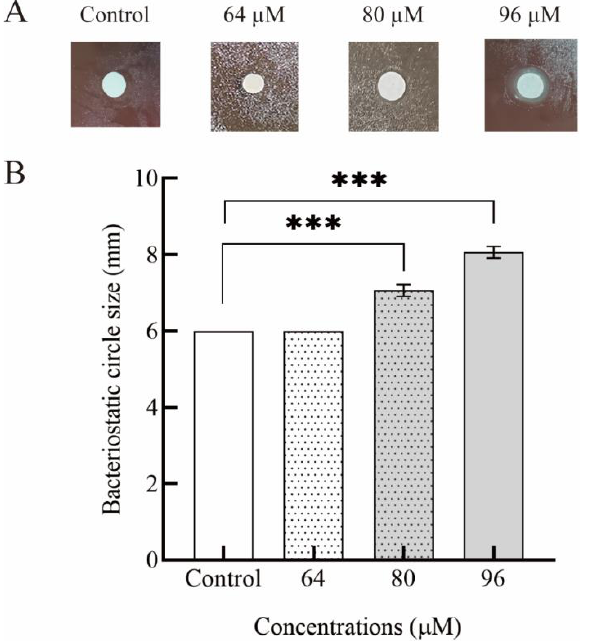
Figure 1. The diameter of the inhibition zone (DIZ) was determined by the filter paper diffusion method. The plates with H. pylori and PLNC8 were incubated at 37 ◦ C in a microaerobic environment for 72 h. ( A ) Inhibitory effect of 0, 64, 80, and 96 µ M PLNC8 on H. pylori ZJC03. ( B ) Inhibitory effect of different concentrations of PLNC8 on H. pylori ZJC03; Control: 0.05% acetic acid buffer; Data are shown as the mean ± SD; n = three groups parallel. *** p < 0.001; no statistical significance was shown.